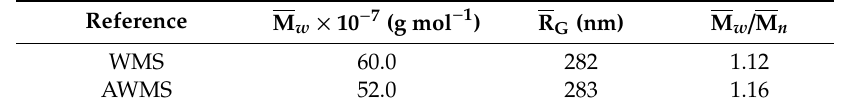
Figure 2. Macromolecular structure of native and acetylated waxy maize starch. ( a ) Elugrams (thin lines) and molar mass distributions (thick lines) of native WMS (blue) and acetylated WMS (AWMS) after deacetylation (black) obtained by AF4-MALLS; ( b ) Chain length distributions of WMS (Blue) and AWMS after deacetylation (Black). DS before deacetylation: 2.6. Table 1. Weight-average molar mass (M w ), z -average radius of gyration (R G ) and dispersity index (M w / M n ) determined by AF4-MALLS for WMS and AWMS after deacetylation;.